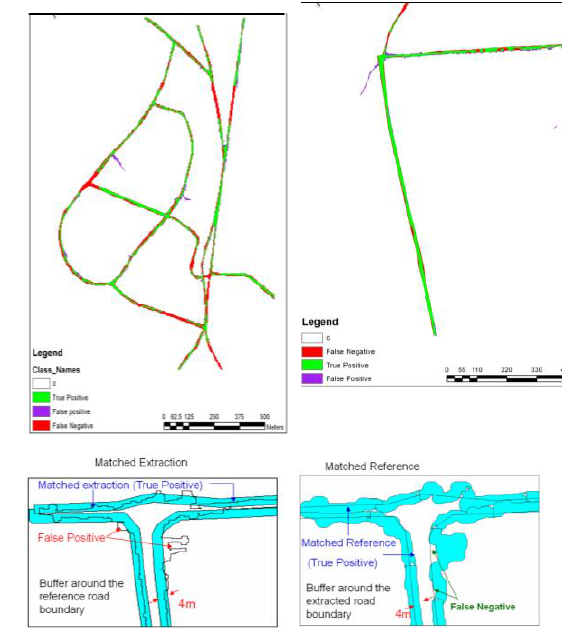
Figure 4 : Road extraction